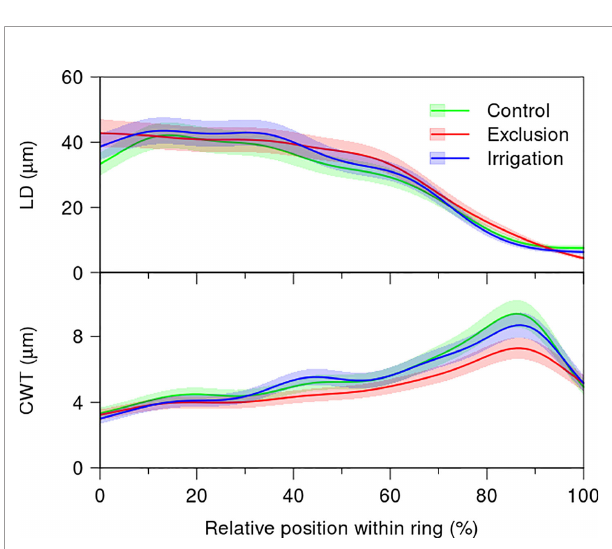
FIGURE 5 | Generalized additive mixed models (GAMMs) fi tted to the radial lumen diameter (LD) and cell wall thickness (CWT) tracheidograms standardized to the relative position of the tracheids within the tree ring in control (green line), irrigation (blue line), and exclusion trees (red line). For detailed information on the GAMM models please see Supplementary Table 2